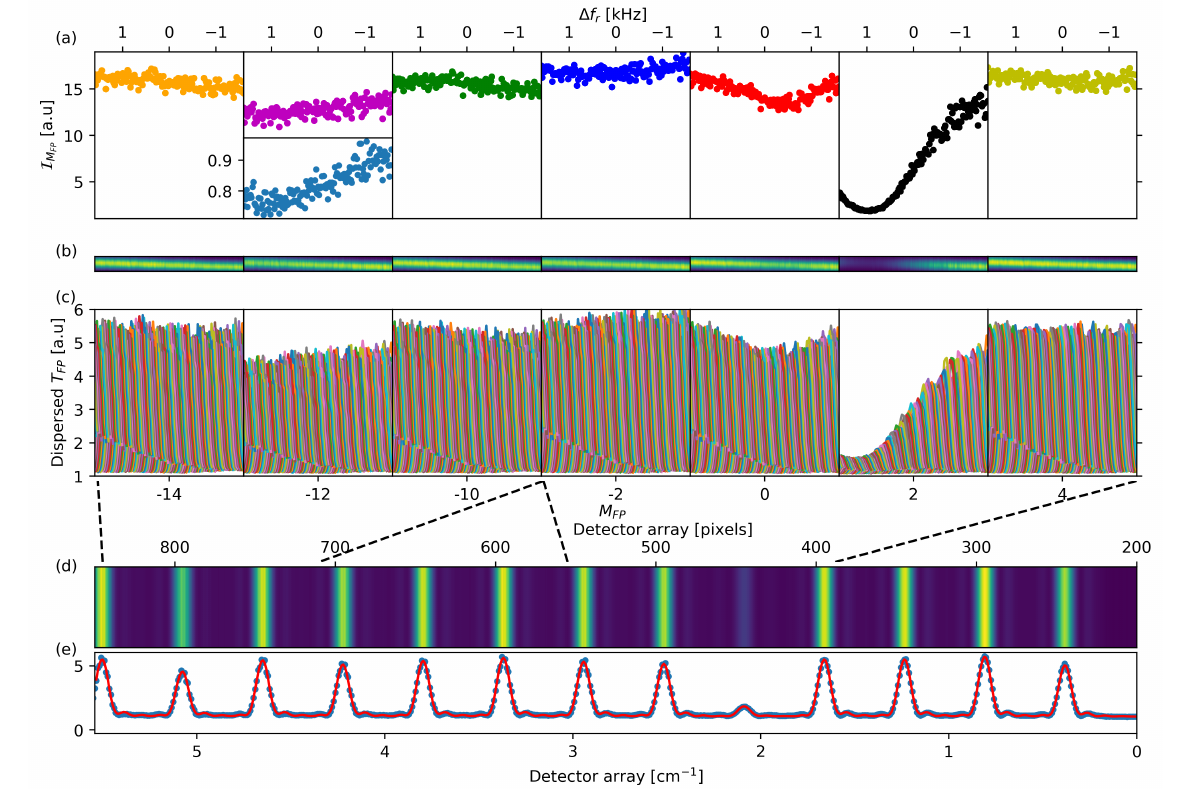
Figure 2. Spectra of the OFC modes filtered by the FP as a function of the OFC’s ∆ f r = f r − f r , with f r repetition rate c c frequency at the center of the scan. The spectra are the result of the analysis of the recorded images of the SOPRA-dispersed fraction of the FP-filtered OFC vs f r . Three of these modes are resonant with the (20 0 1-00 0 0) R(14) of 13 C 16 O 2 @ 5002.21 cm − 1 , (20 0 1-00 0 0) R(18) of 13 C 16 O 2 @ 5004.84 cm − 1 , and (20 0 1-00 0 0) P(45) of 12 C 16 O 2 @ 5005.27 cm − 1 ro-vibrational transitions; the other modes are not absorbed by the CO 2 molecule. The modes are identified by the FP order scale of panel ( c ): the 12 C 16 O − 12, 0 and +2 orders are the modes absorbed by 13 C 16 O − 14, − 10, − 2 and 2 and 2 transitions, respectively; the +4 orders are the not-absorbed ones. ( a ) Integrated transmission spectrum. ( b ) Spectral behavior of the array images for each mode. ( c ) Spectral behavior of the SOPRA-resolution wavelet for each mode. ( d ) Detector array image of the portion of the FP-transmitted OFC modes for a given f r . ( e ) Vertically integrated intensity of the transmitted modes of image in panel ( d ) and the fit to a function resulting form the addition of 13 SOPRA-resolution functions; the intensity of the fitted resolution provides the transmission spectra values for each f r of panel ( a ). The inside graph of panel ( a ) shows the transmittance spectrum of the R(14) transition of the 13 C 16 O 2 from the M = − 12 mode normalized by the average intensity of the − 14 and − 10